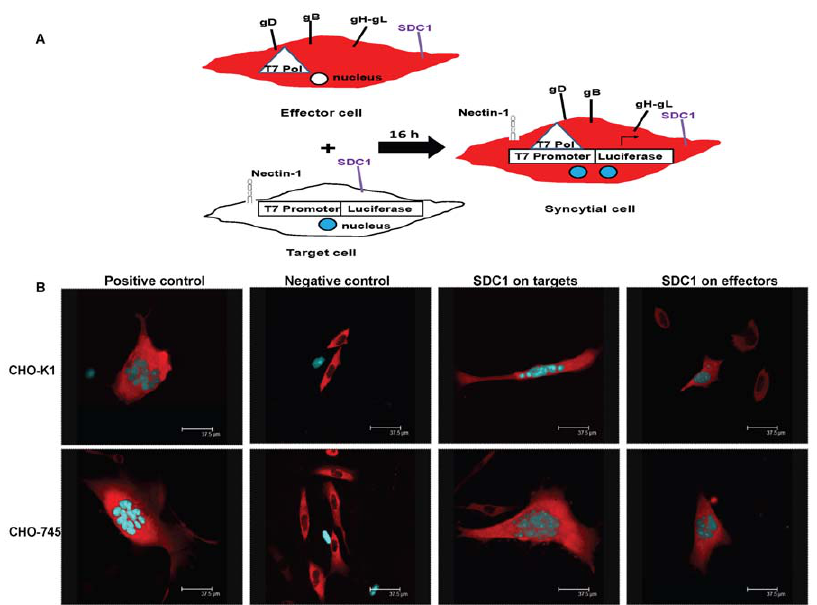
Figure 3. Syncytial cell formation in CHO-K1 and CHO-745 after syndecan-1 overexpression. (A). An illustration of syncytia assay that was exploited to understand the contribution of syndecan-1 during HSV-1 induced cell-to-cell fusion. Effector cell population that expresses HSV-1 fusion glycoproteins, T7 polymerase as well as a RFP-NES construct that restricts the expression of RFP to the cytoplasm is mixed with the target cell population that expresses nectin-1 as a gD receptor, the luciferase reporter gene under the control of T7 promoter as well as a CFP-NLS construct that restricts the level of CFP to the nucleus. (B). Syncytia formation was observed in cells 72 h after the mix of target cells with effector cells. Top panels show representative syncytia formed in CHO-K1 cells after overexpressing syndecan-1 in target, or effector cell. Bottom panels show representative syncytia formed in CHO-745 cells after overexpressing syndecan-1 in target, or effector cells. Positive controls are target cells mixed with effector cells where both populations have the wild-type level of syndecan-1 on the surface. Negative controls are target cells mixed with effector cells missing gB. (Scale bar=37.5 m m). SDC1 , syndecan-1.